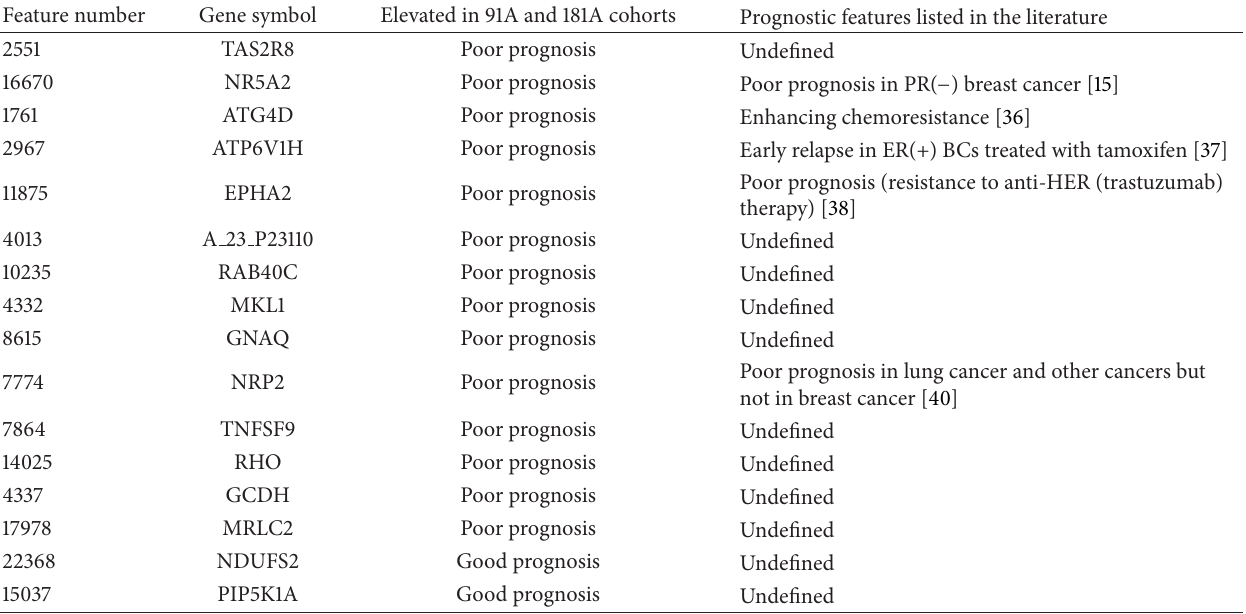
Table 1: Literature based validation of 16 prognostic predictors predicted in the NR5A2 transcriptional regulatory network. Feature number